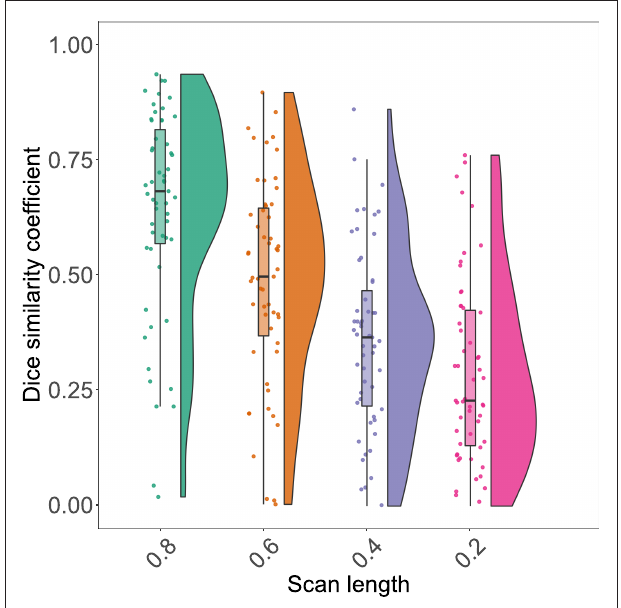
FIGURE 2 | Raincloud plots showing the distribution of Dice similarity coefficients (y axis) representing the degree of spatial overlap between BOLD delay lesions derived from resting-state functional MRI scans of different lengths (x axis) and the BOLD delay lesions derived from the full scan.